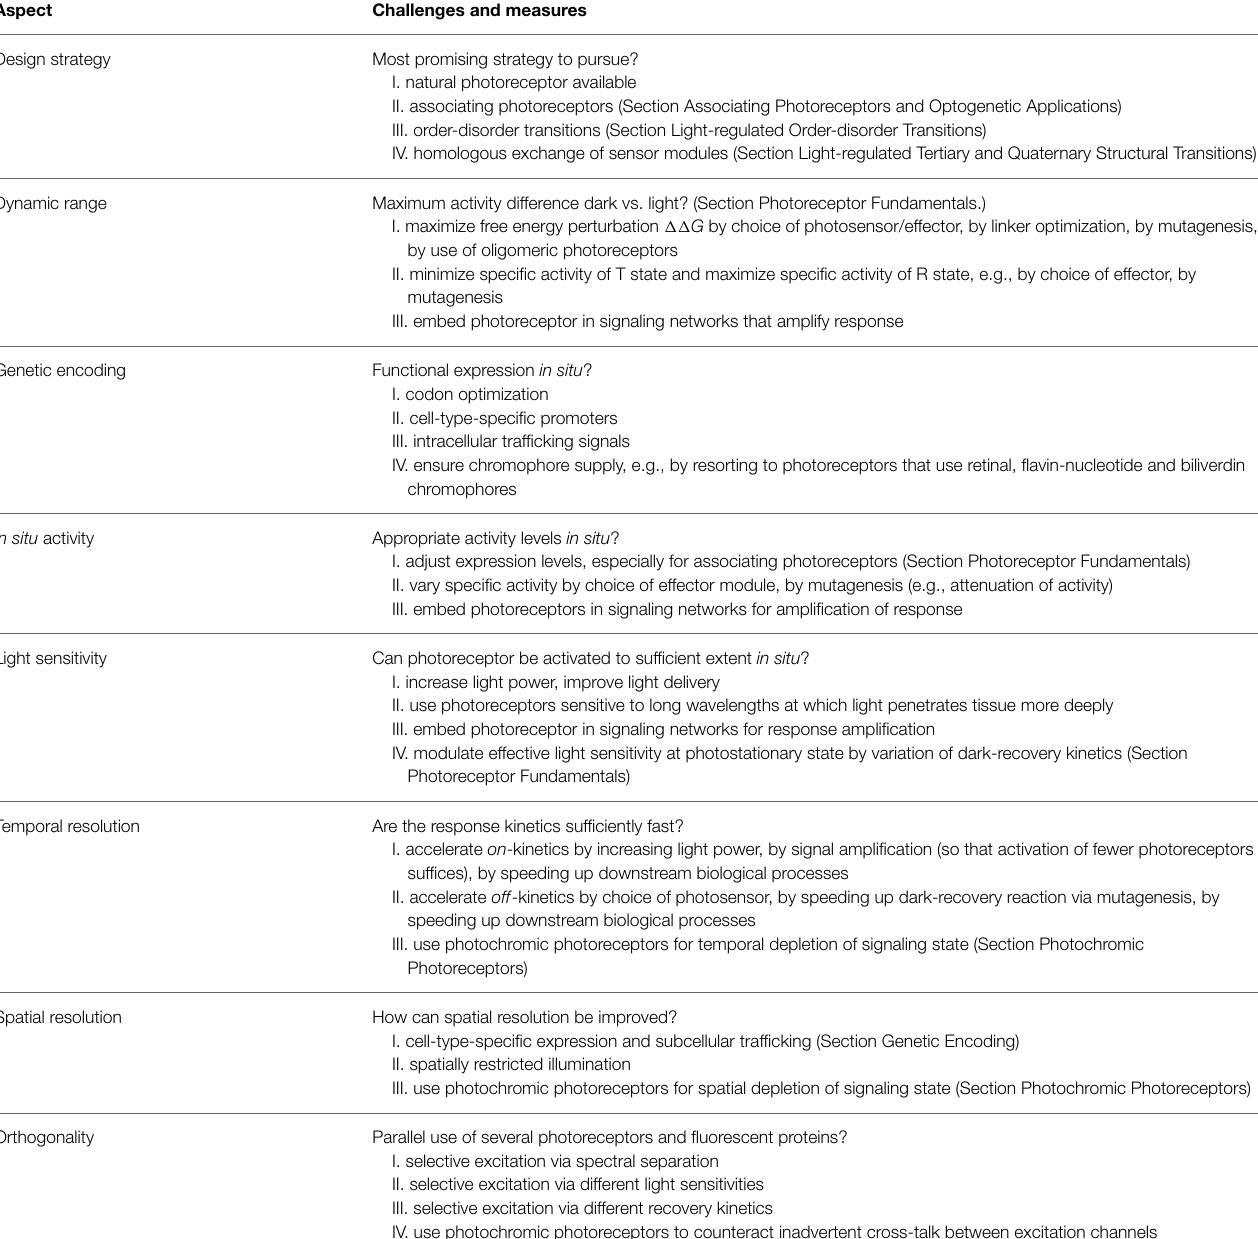
TABLE 4 | Desiderata in photoreceptor